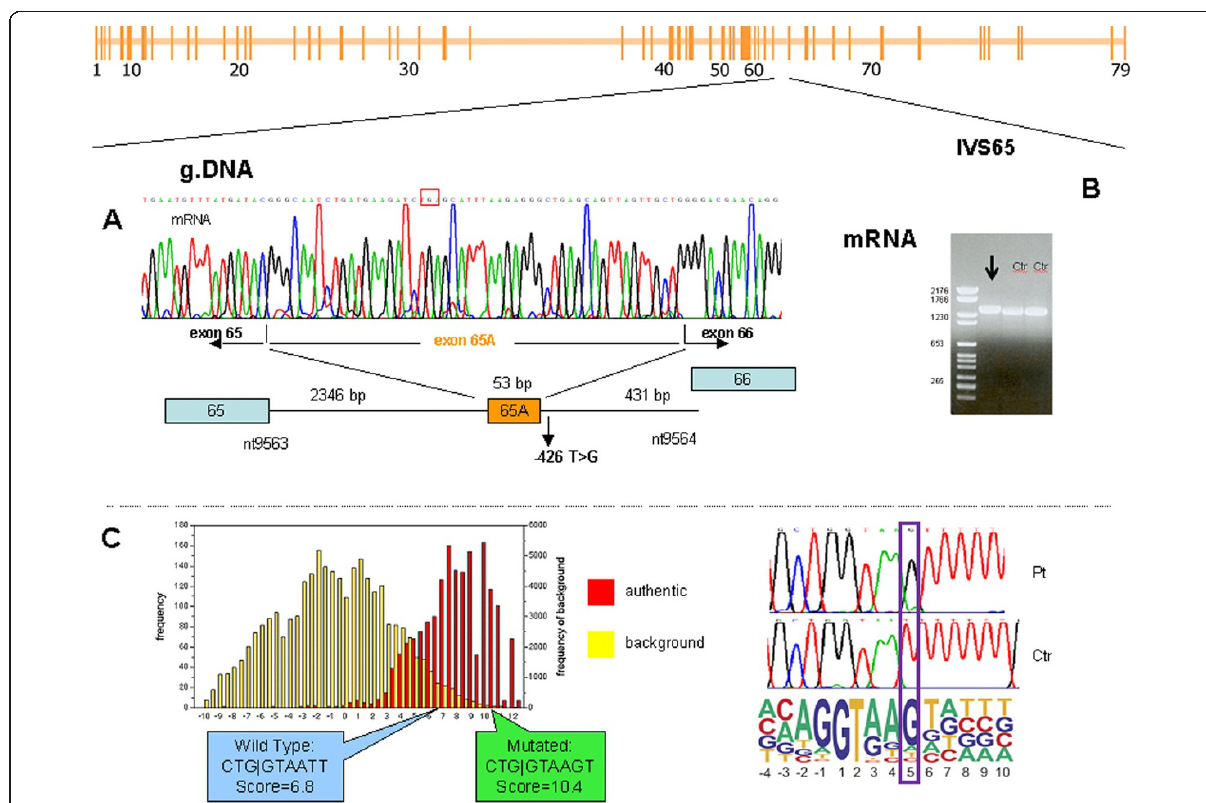
Figure 6 Patient XL: An intronic nucleotide substitution activates a cryptic splice site leading to pseudoexon creation . The mutation is localized in intron 65 (see schematic representation of the DMD gene). A. Sequence analysis. The electropherogram depicts the insertion of 53 bp between exons 65 and 66. This insertion creates a stop codon (TGA, red box) and results in the production of a truncated protein (p. Thr3188ThrfsX7). The insertion is determined by a nucleotide substitution (c.9564-426T>G) in IVS 65, which activates a cryptic splice site. The schematic representation of IVS65 under the electropherogram depicts the position of the intronic mutation and the sequence inserted into intron 65. B. cDNA analysis depicts a band with higher molecular weight than control (Ctr) in the patient, demonstrating the insertion of 53 bp. C. Bioinformatic analysis: 5 ’ Splice Site score distribution in patient (mutated, green) versus control (wild type, blue). The mutation is localized in a silent splice site consensus sequence included in the intron and increases the MaxENT score, that gives the probability that a sequence is a functional splice site, from a value of 6.8 to a value of 10.4. The obtained maxENT scores, suggest that the mutation activates a cripitc 5 ’ ss leading to inclusion of the exon in the mature transcript. The substitution involves one of the most important and conserved bases of the consensus sequence, as shown in the schematic representation on the right, which illustrates the relative frequency of different bases in the 5 ’ splice site consensus sequence (the size of the letter indicating each nucleotide reflects its importance in the consensus